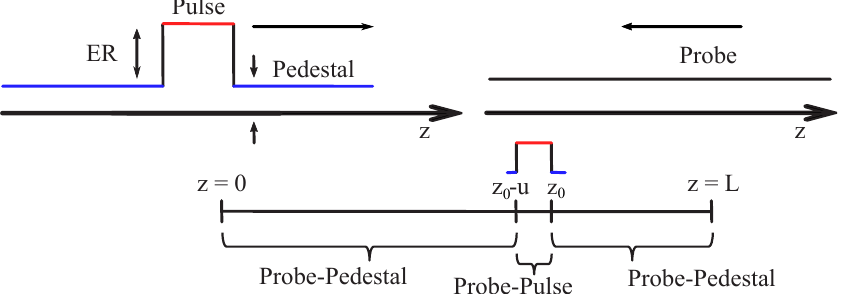
Figure 6. Schematic description of probe and pulse waveform interaction along the fiber for an extinction ratio (ER) limited pump pulse